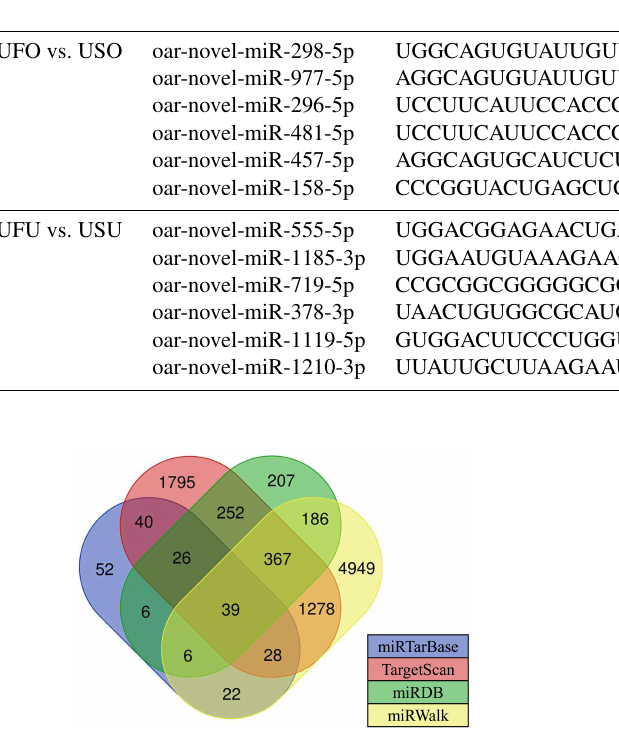
Table 3. Relatively higher abundance 12 novel miRNA position on the genome and its sequence in UF and US libraries. Groups UFO vs. USO